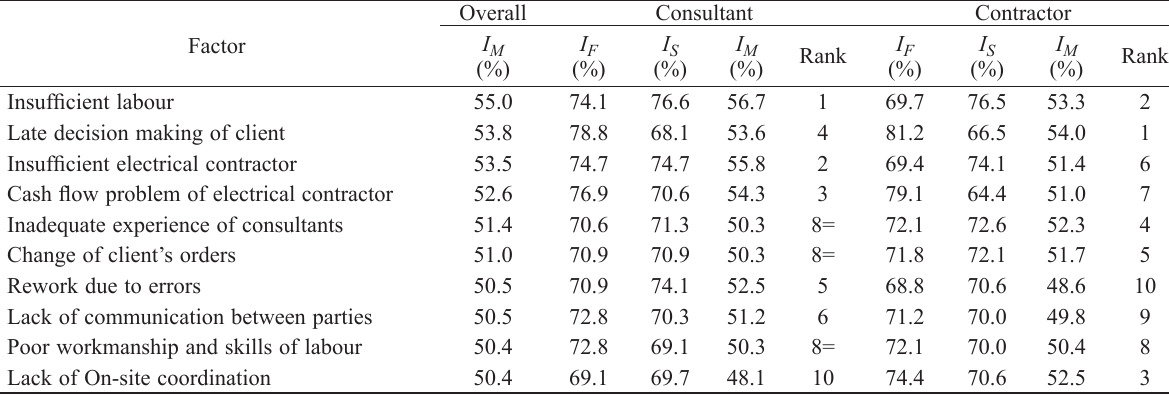
Table 2. Indices and ranks of the top 10 delay factors Overall Consultant Factor